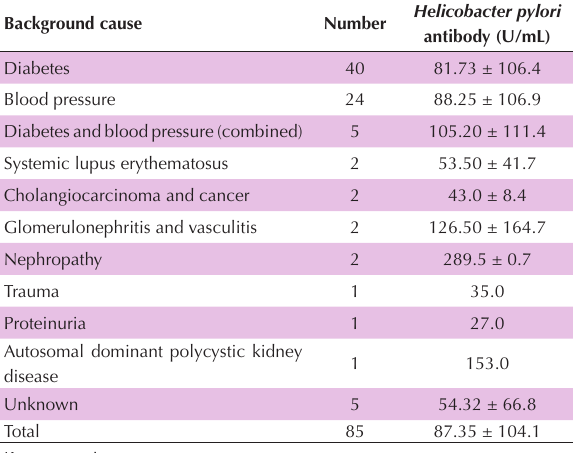
Table 5. Comparison of mean Helicobacter pylori antibody levels based on primary cause of chronic kidney disease Background cause